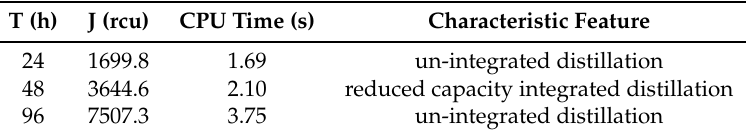
Table 7. Solution statistics for BR-S system for different scheduling